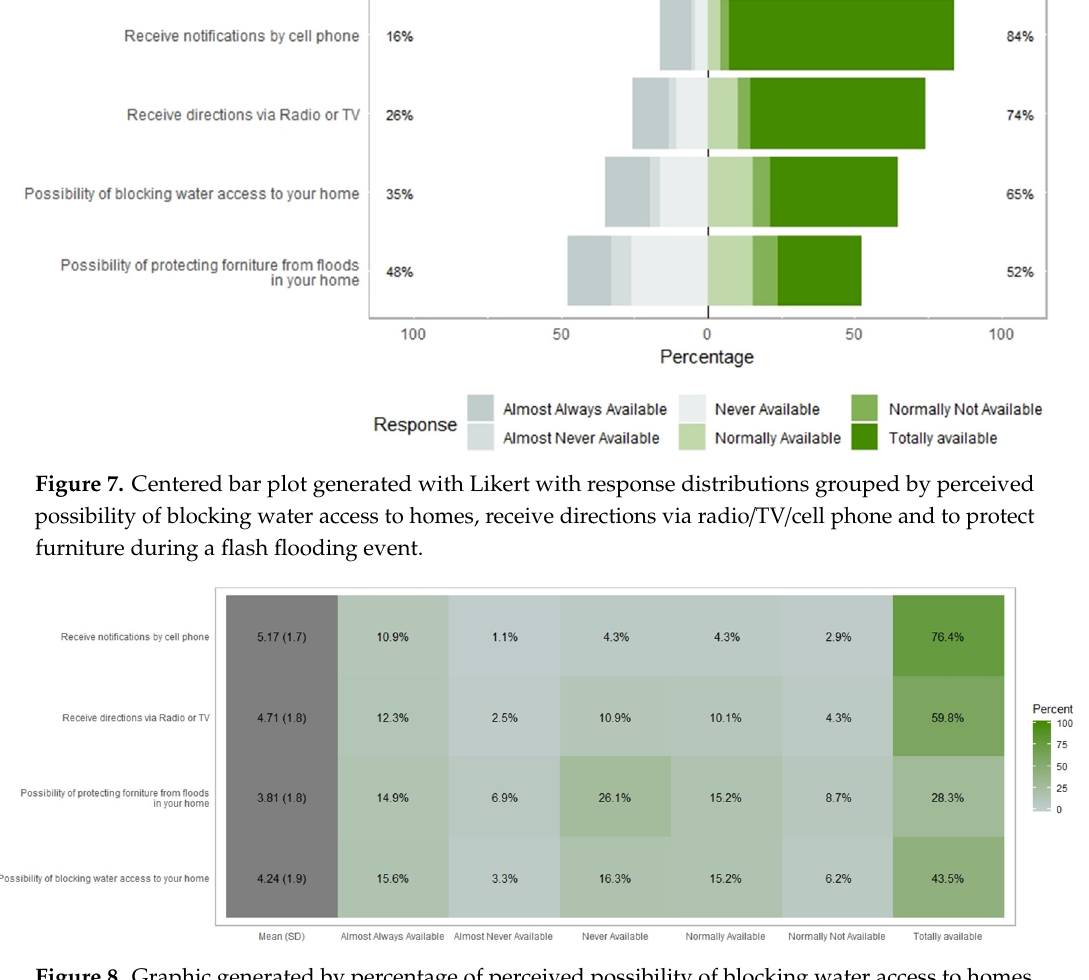
Figure 8. Graphic generated by percentage of perceived possibility of blocking water access to homes, receive directions via radio / TV / cell phone and to protect furniture during a flash flooding event. Table 1. Statistics of the perception and resilience index to flooding in the study area of Colima-Villa de Alvarez, Mexico.